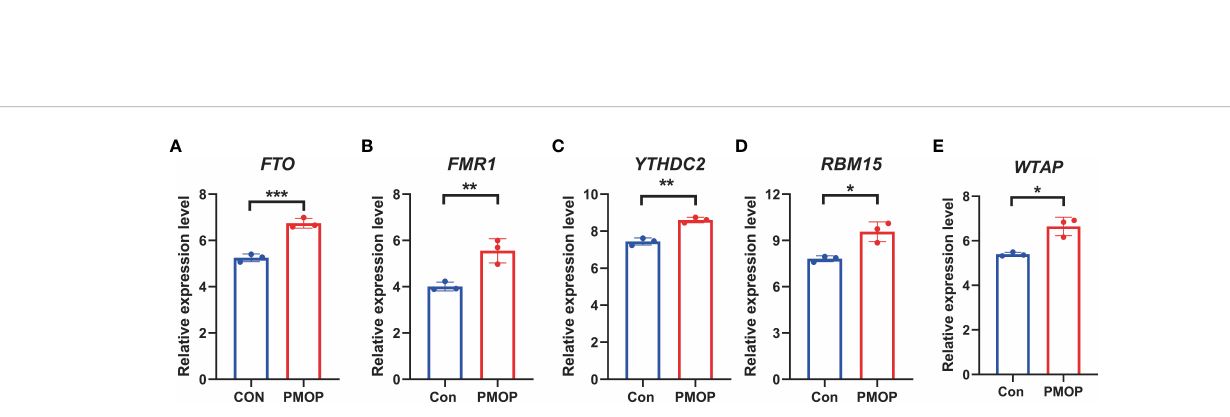
FIGURE 10 RT-qPCR experimental validation of signi fi cant m6A modulators. (A – E) Relative mRNA expressions of 5 key m6A modulators including FTO, FMR1, YTHDC2, RBM15 and WTAP between the two groups. All results were expressed as mean ± standard deviation. *p < 0.05, **p < 0.01, and ***p <